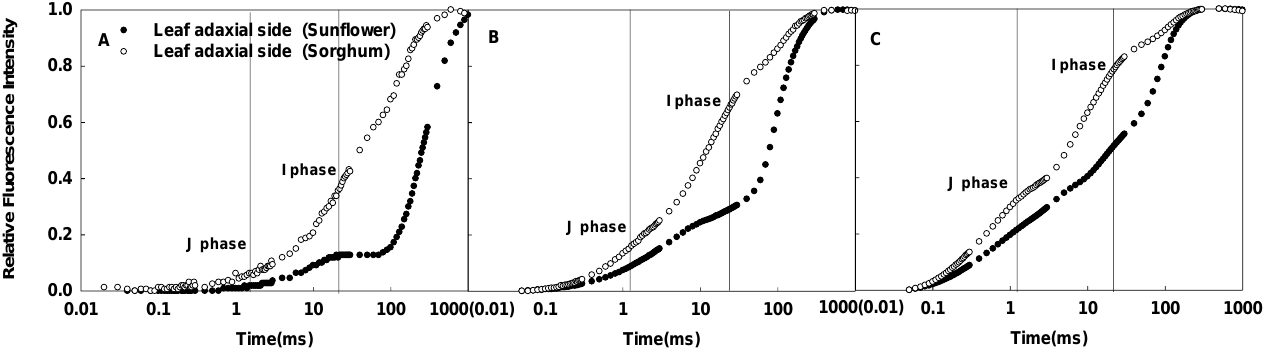
Figure 8. Differences in the CFI curves of the adaxial sides of sunflower and sorghum leaves under various pulsed light intensities. The CFI curves are presented as means values of the relative variable fluorescence (V t ). The pulsed light intensities were 200 ( A ), 1000 ( B ), and 3000 ( C ) µmol·m −2 ·s −1 .